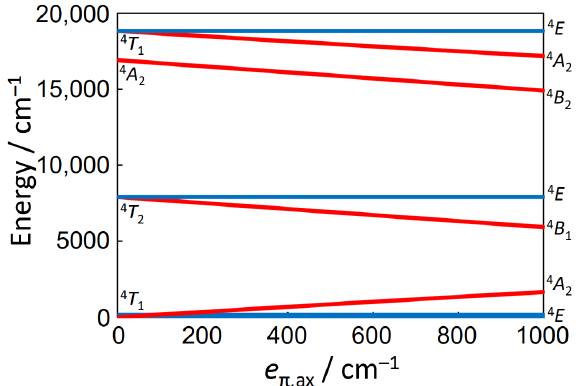
Figure 7. Energy level diagram for octahedral high-spin cobalt(II) complexes with respect to the enhancement of e π ,ax . Racah and AOM parameters: B = 800 cm −1 , C = 3200 cm −1 , e σ,av = 3000 cm −1